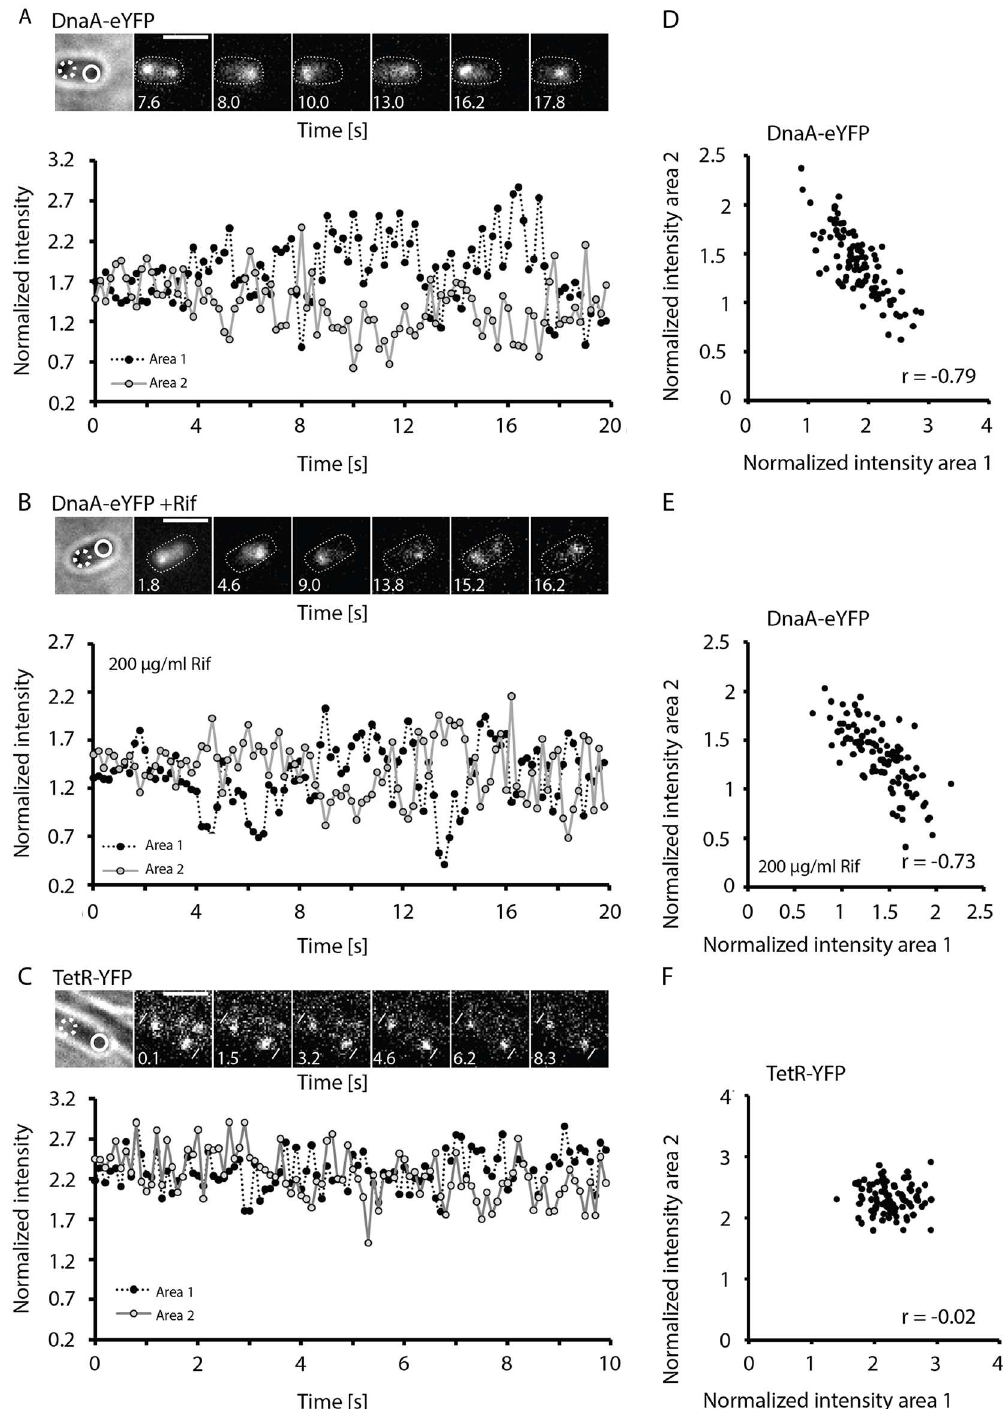
Fig 9. Oscillation of DnaA-YFP sw in E . coli . Fluorescence microscopy images of E . coli cells, A) expressing DnaA-YFP sw duringexponentialgrowth, B) 60 min after the addition of 200 μ g/ml rifampicin, C) B . subtilis cells expressingTetR-YFP bindingto a tetO array near oriC . Fluorescence intensitiesof two areas, each containing one fluorescence signal, were measuredand normalizedto the total fluorescence intensity of the cell. Intensities of both areas were plotted over time. Area 1 (black) and area 2 (white). Image sequencesdisplayingthe oscillationof DnaA-YFP sw (A–B) and the static TetR-YFP (C) are shown. White lines, cell borders; scale bars, 2 μ m; white